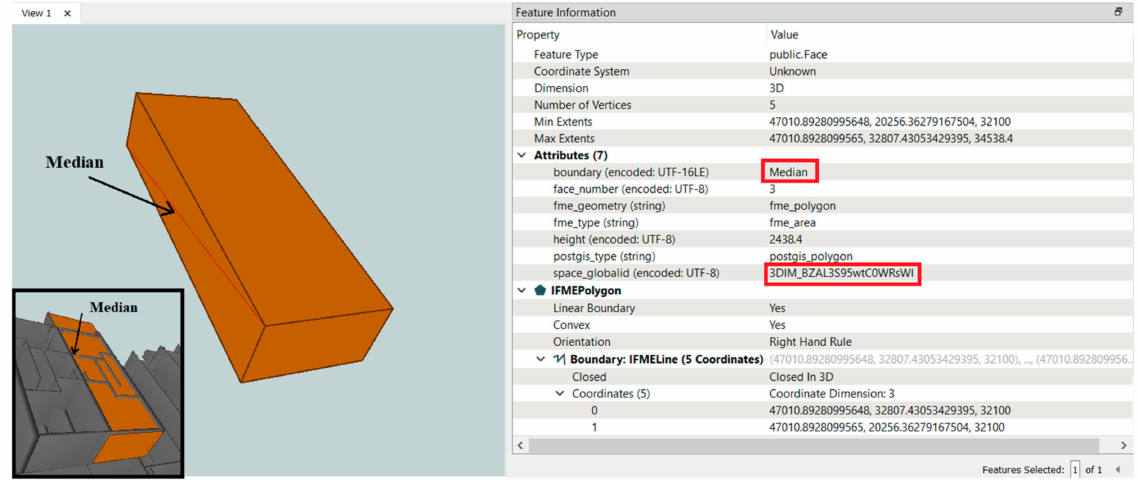
Figure 23. A median boundary for the lot with the Globalid: 3DIM_BZAL3S95wtC0WrsWI.